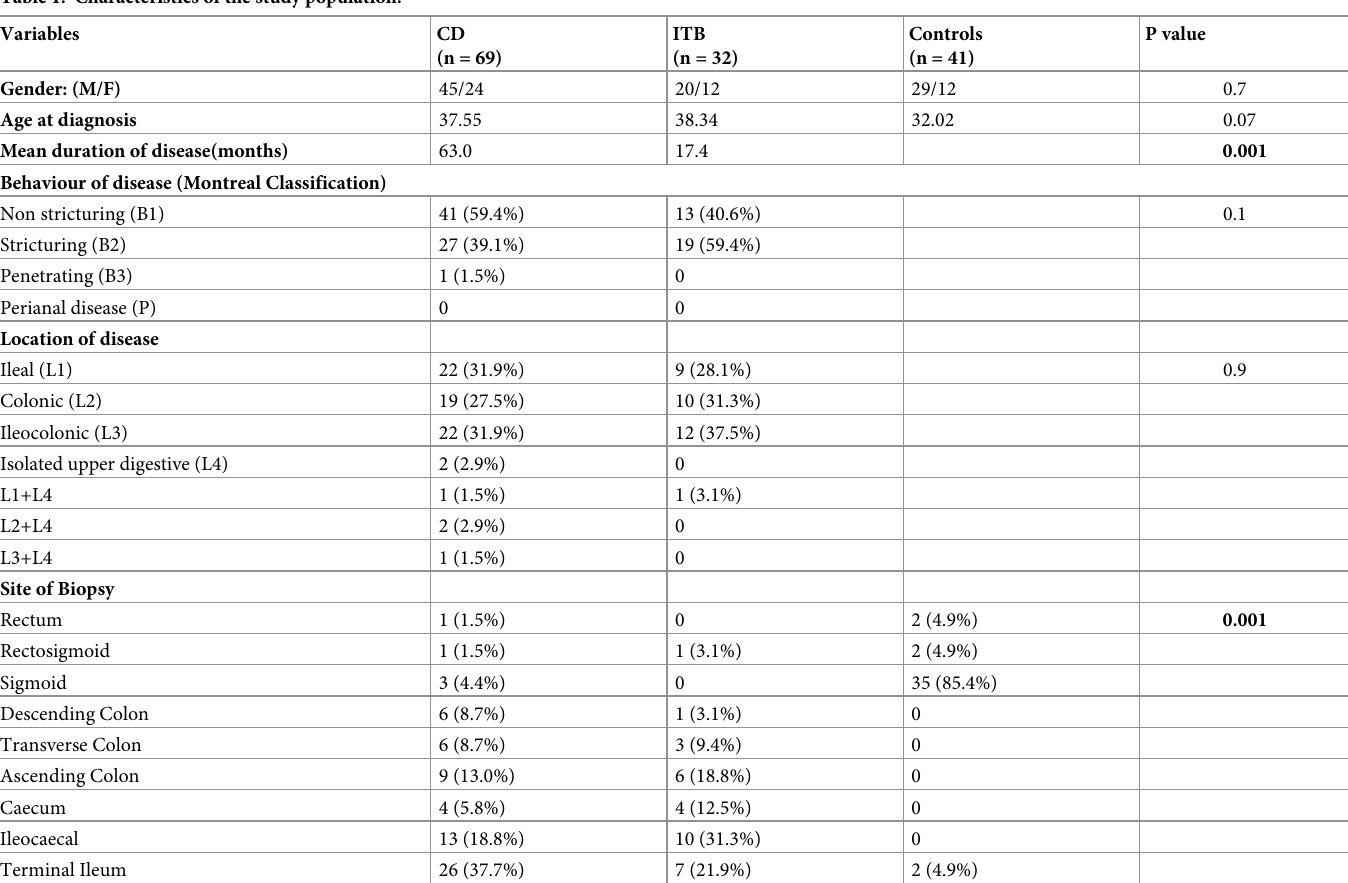
Table 1. Characteristics of the study population.